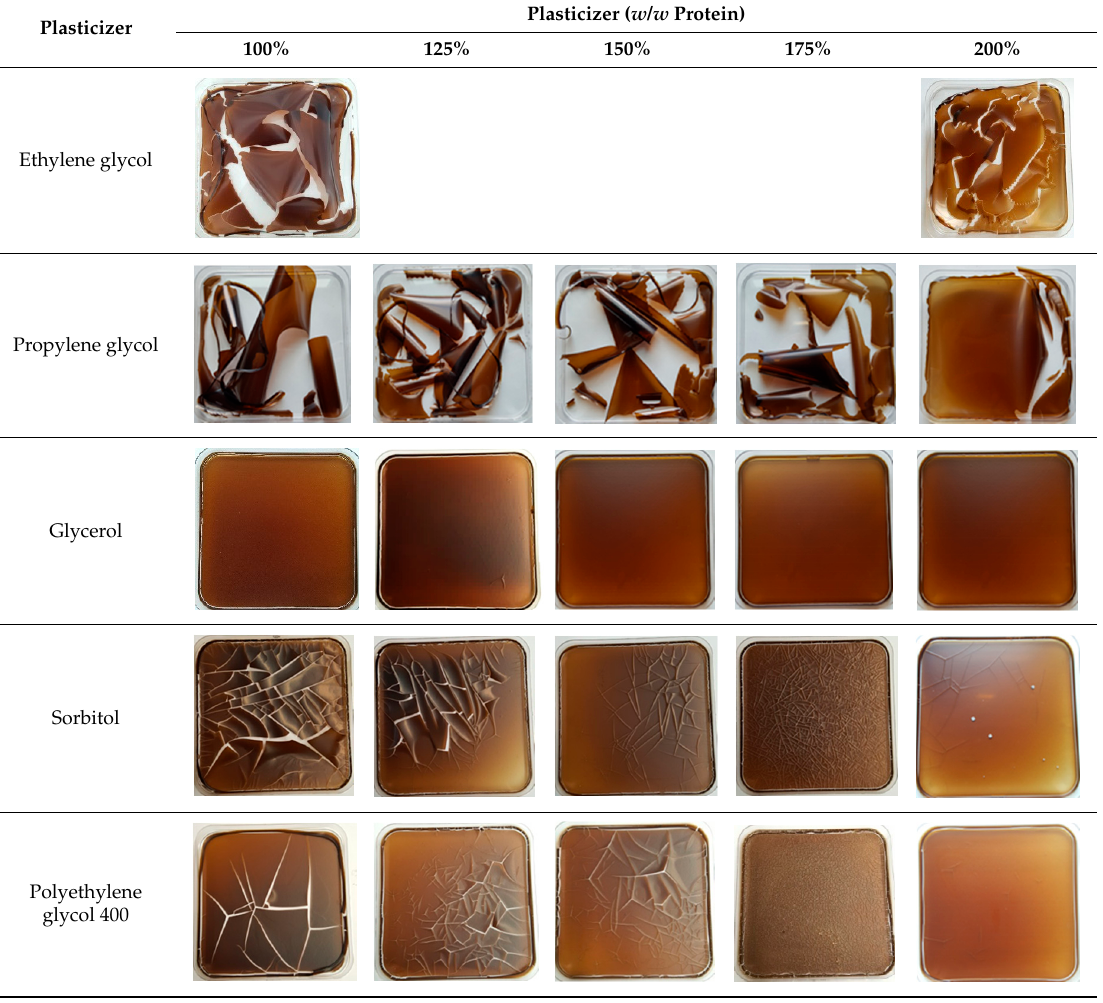
Propylene glycol